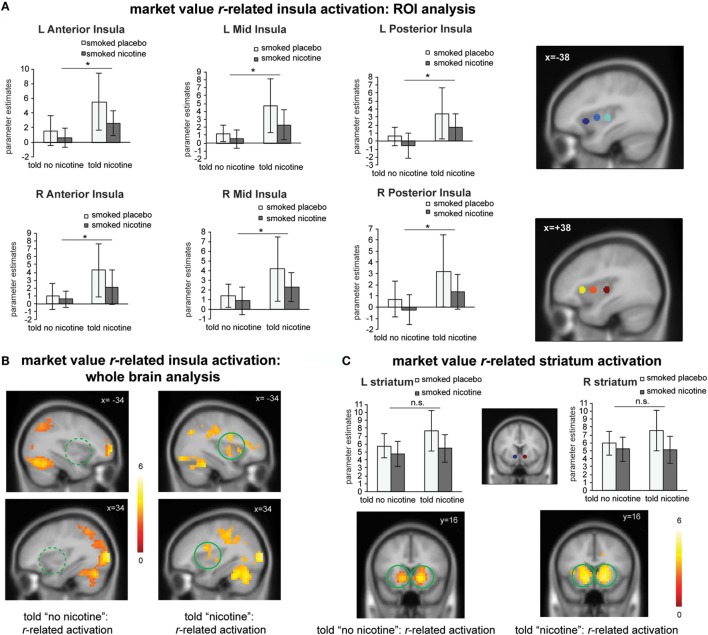
(A) Region-of-interest (ROI) analysis suggests that “told nicotine” elicited greater market value r-related activations in bilateral anterior, mid, and posterior insula regions compared to “told no nicotine” (main effect of belief, Ps < 0.05). ROIs were selected from a meta-analysis on interoception from www.neurosynth.org. (B) Whole brain analysis confirmed that market value r-related insula activation was only significant when subjects were told “nicotine,” but not when they were told “no nicotine” (P < 0.05 corrected for family wise error). The contrast between the two maps is also significant for the insula (see Results, P < 0.05 corrected). (C) Both ROI and whole brain analysis show that striatum activation related to market value r did not significant differ between the “told nicotine” and “told no nicotine” conditions at the same threshold of (A,B). The contrast between two conditions is also non-significant for the striatum even with small volume correction. *P ≤ 0.05. L, left; R, right. Error bar represents 95% confidence interval.